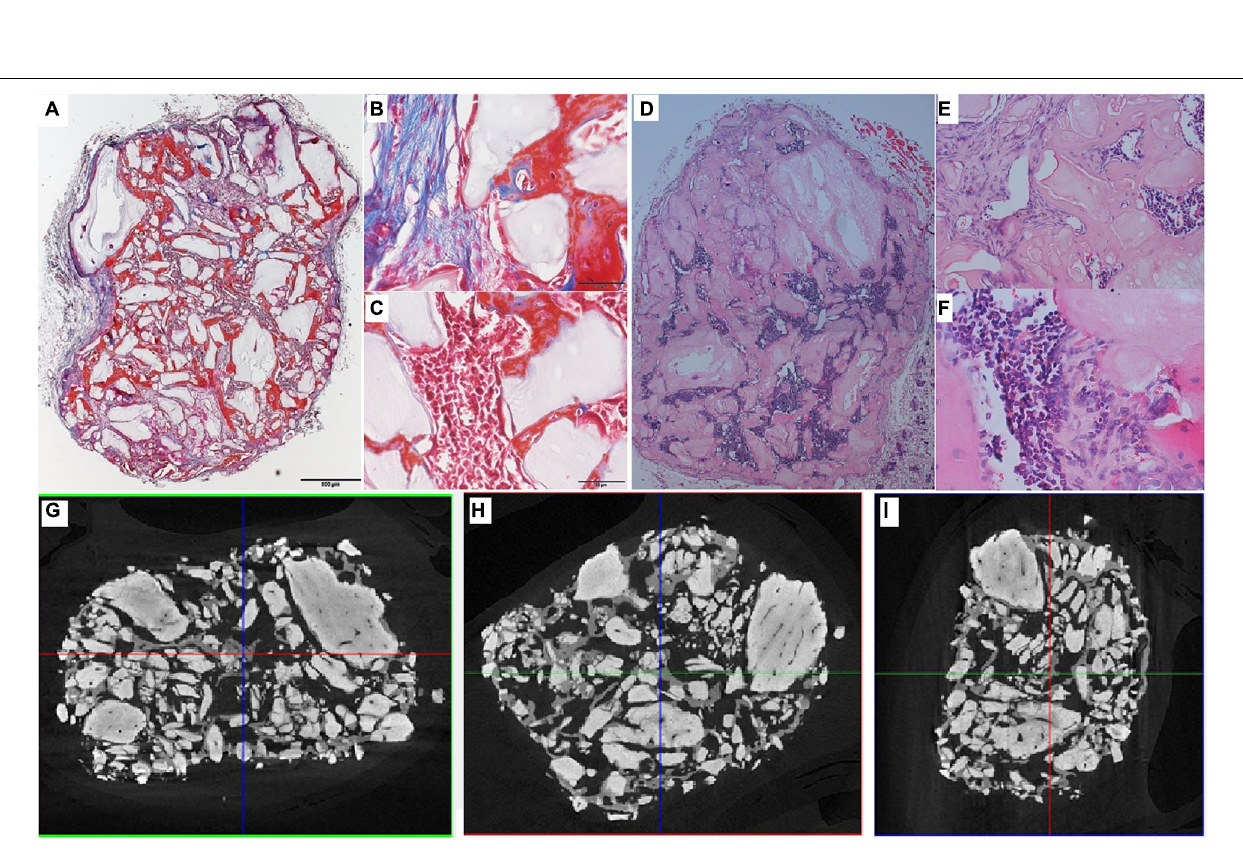
Frontiers in Bioengineering and Biotechnology |